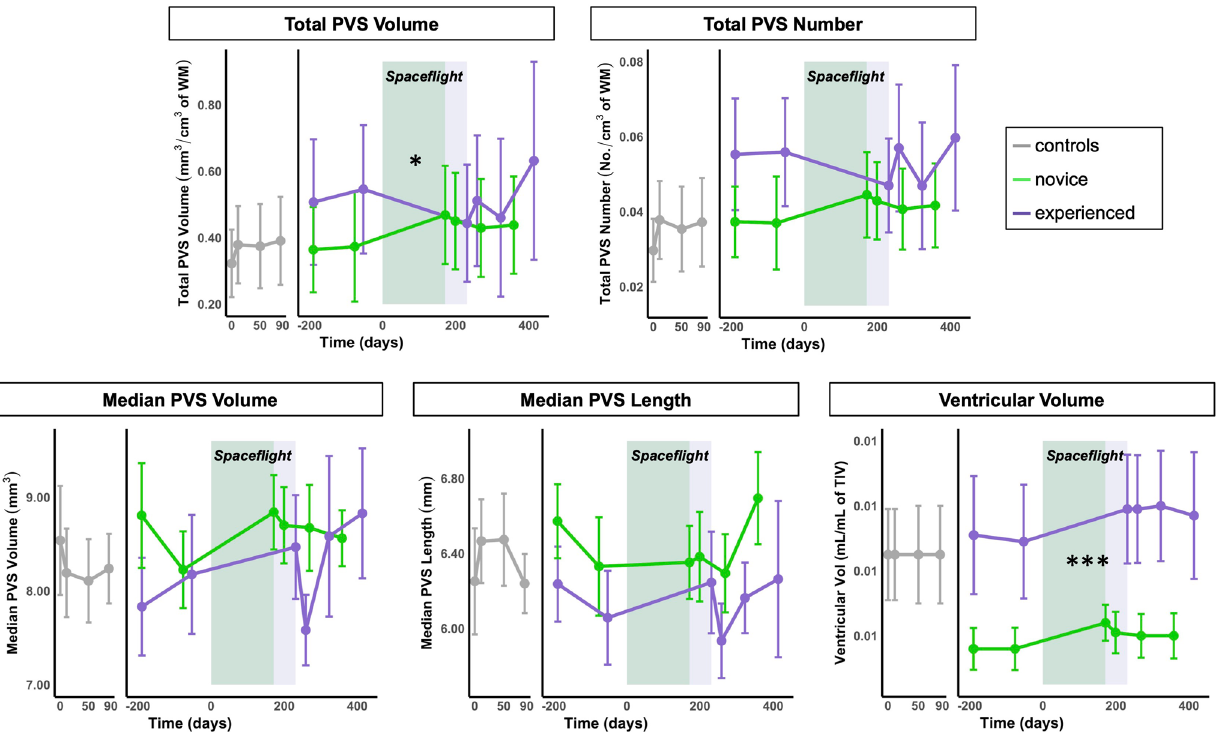
Figure 3. Changes in PVS metrics and ventricular volume from pre- to post-flight. Group average PVS characteristics are depicted for each of the four control group time points (gray, left panels) and for each of the six astronaut time points (right panels). The astronaut data are split into novice (green) and experienced (purple) subgroups. Bars represent standard error. The width of the green and purple boxes indicates the average flight duration for novice and experienced astronauts, respectively. *Indicates a statistically significant ( p < 0.05) group difference between the novice and experienced astronauts for changes in total PVS volume with spaceflight. ***Indicates a statistically significant ( p < 0.001) change in ventricular volume from pre- to post- flight. The second astronaut time point depicts group-average data for n = 8 (instead of 9) novice astronauts; the final astronaut time point depicts group-average data for n = 13 (instead of 15) experienced astronauts (see “Methods” for details on these missing data). We included only complete control group datasets, so n = 11 for all control time points. WM white matter, TIV total intracranial